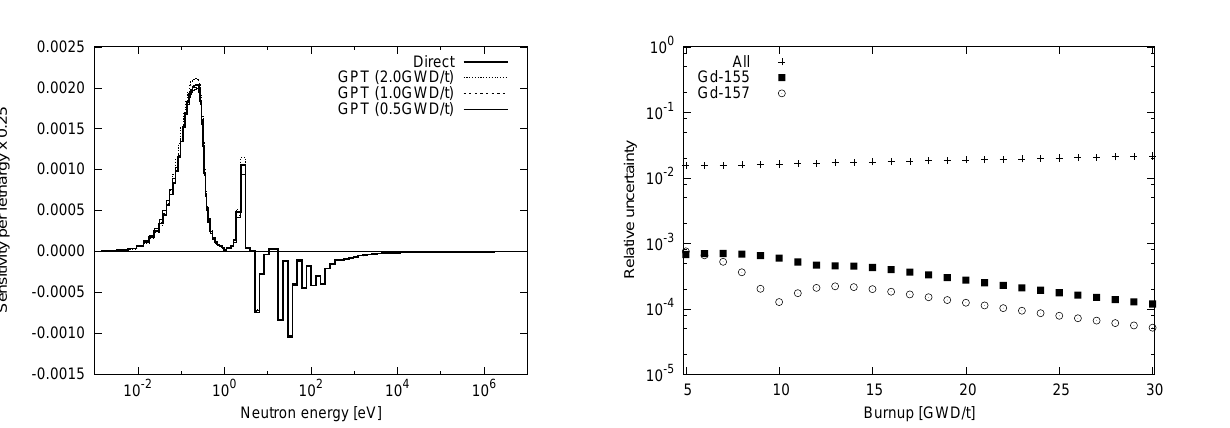
Figure 8. Nuclear data-induced uncertainty in Pu-239 number density during burnup